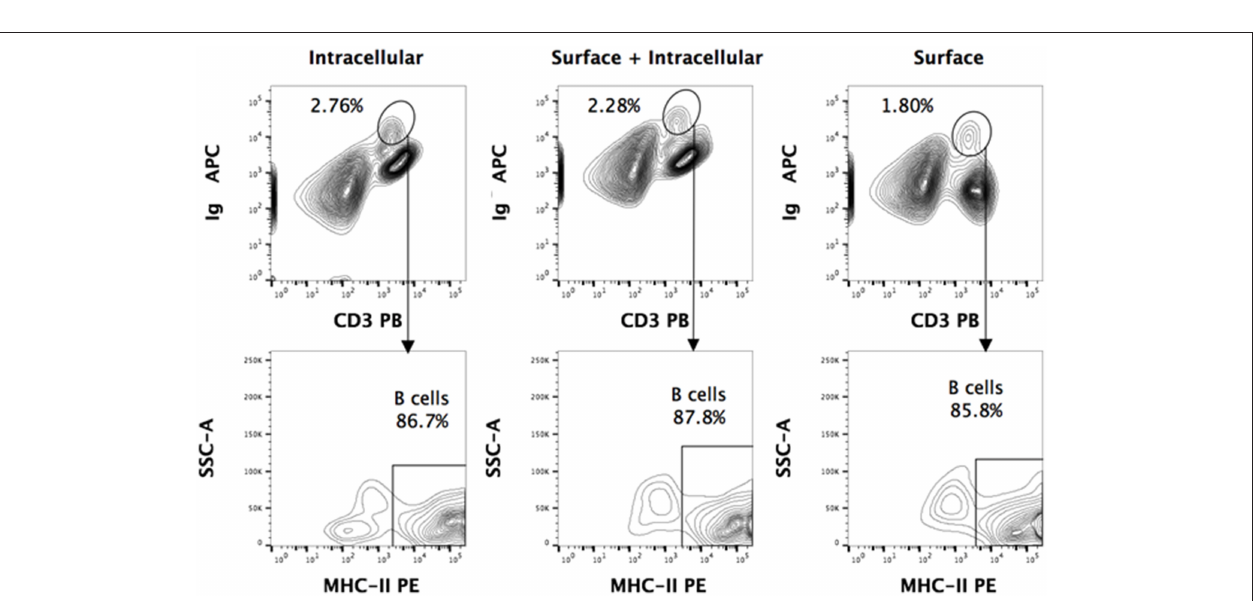
FIGURE 2 | Intracellular and surface Ig staining of P. alecto splenocytes. Dead cells were excluded using Live/Dead eFluor 506 dye and live cells were gated for singlets using forward scatter height (FSC-H) and area (FSC-A). For all the staining approaches (surface only, intracellular only, or surface + intracellular), a distinct sIg + CD3 + / − population is observed. Greater than 85% of this population is MHCII + . Comparable percentages of these cells were obtained with surface staining only vs. intracellular staining only, thus strongly suggesting that this population is truly a sIg + B cell population.